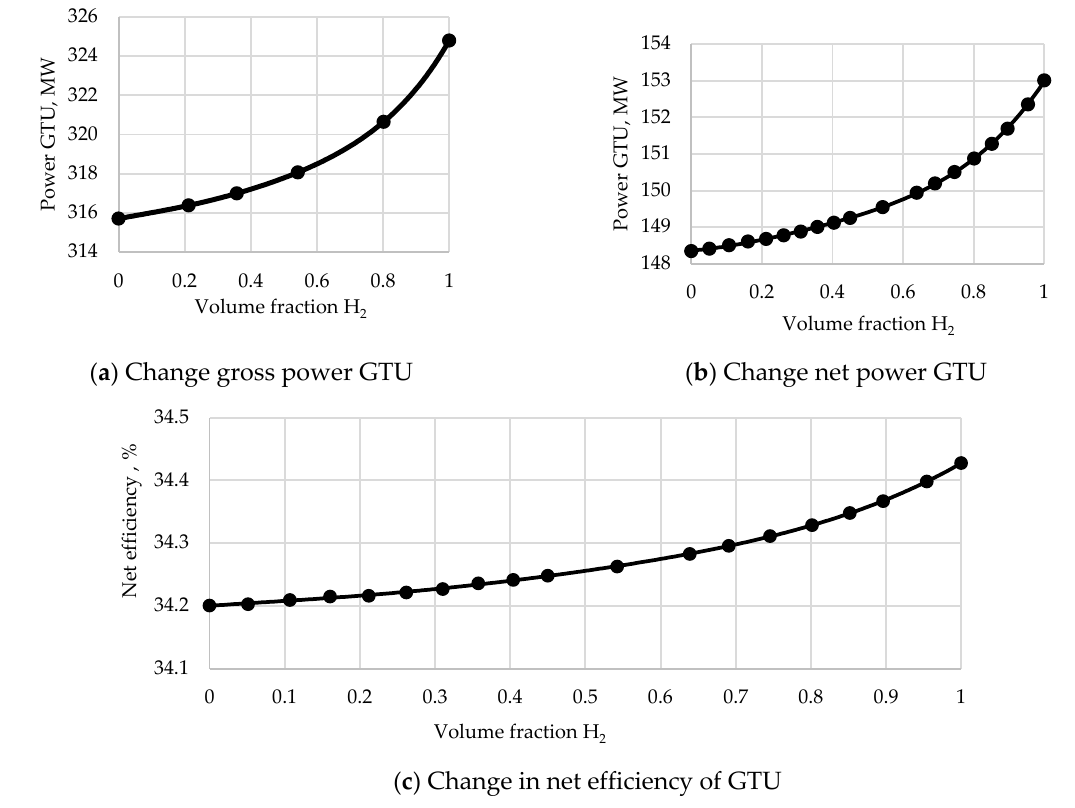
Figure 9. Dependence of GTU energy parameters on the volume fraction of hydrogen.